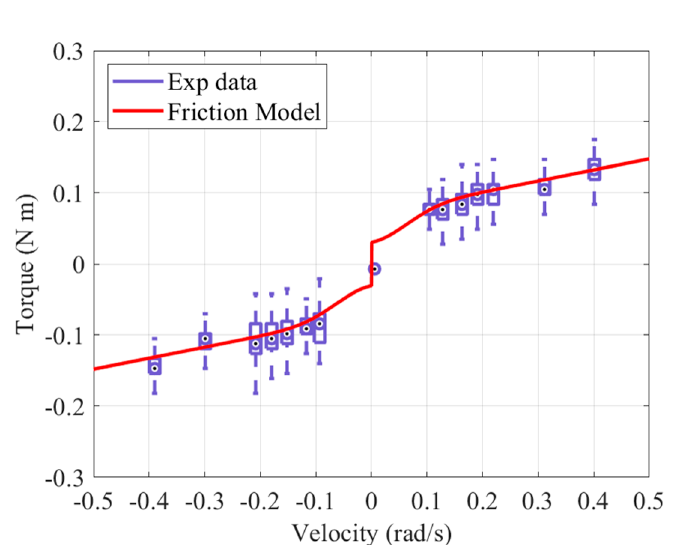
Table 3. Static parameters of the LuGre model.